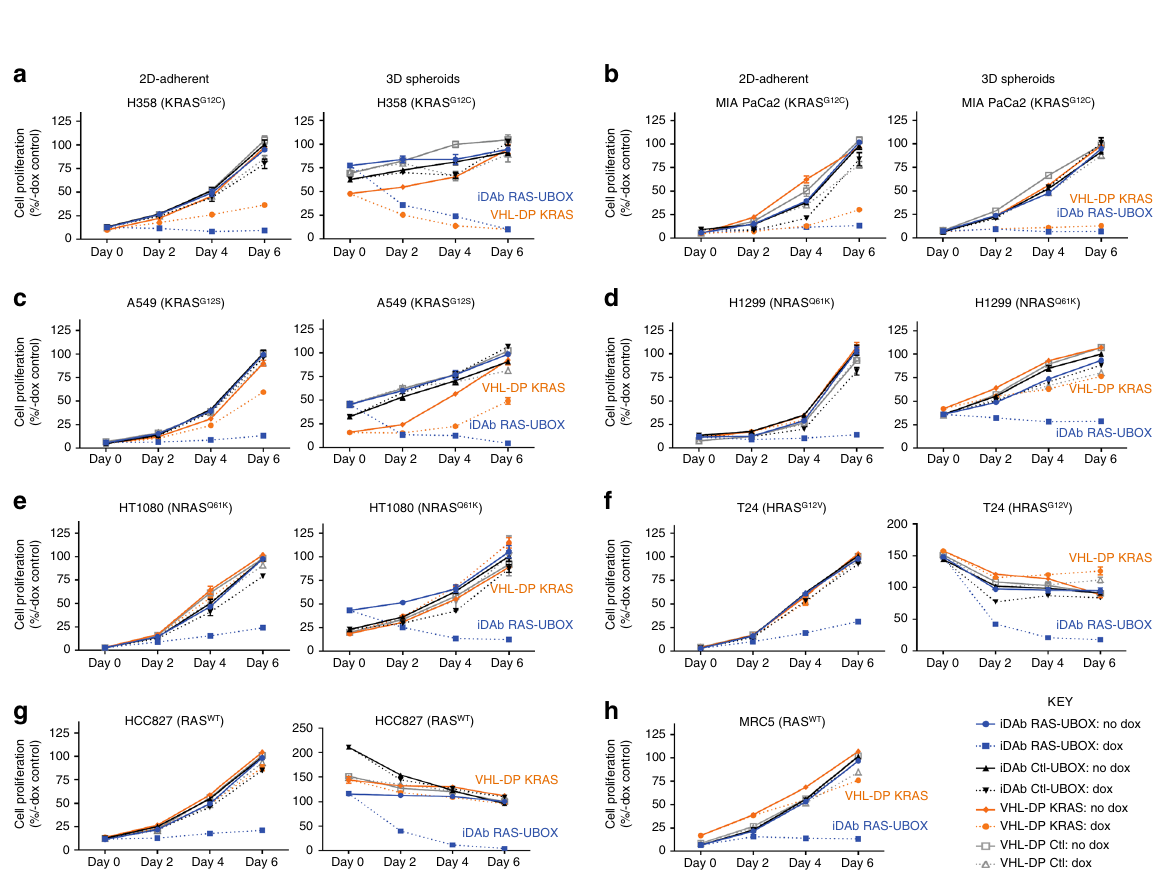
Fig. 6 The KRAS degrader speci fi cally inhibits the proliferation of cells expressing mutant KRAS. Assessment of the effect of pan-RAS and KRAS degraders on 2D-adherent and 3D spheroids proliferation of various cell lines. Mutant KRAS lines a H358, b MIA PaCa2 and c A549 stable cell lines. d , e Mutant NRAS lines: d H1299 and e HT1080. f Mutant HRAS T24 cell line. g , h Wild-type RAS cell lines: g HCC827 and h MRC5. Note that MRC5 cells do not grow as spheroids in 3D low attachment plates, since as untransformed cells, they need anchorage to grow. All proliferation assays (2D and 3D) were normalised to the no dox condition for each cell line. The dotted lines represent the dox-treated cells while the plain lines show the no dox conditions. Each experiment in a – h was performed at least three times. Error bars in a – h are mean ± SD from at least three biological repeats ( n = 3 in ( a – c , g ) and n = 4 in ( d – f , h )). a – h Source data are provided as a Source Data fi